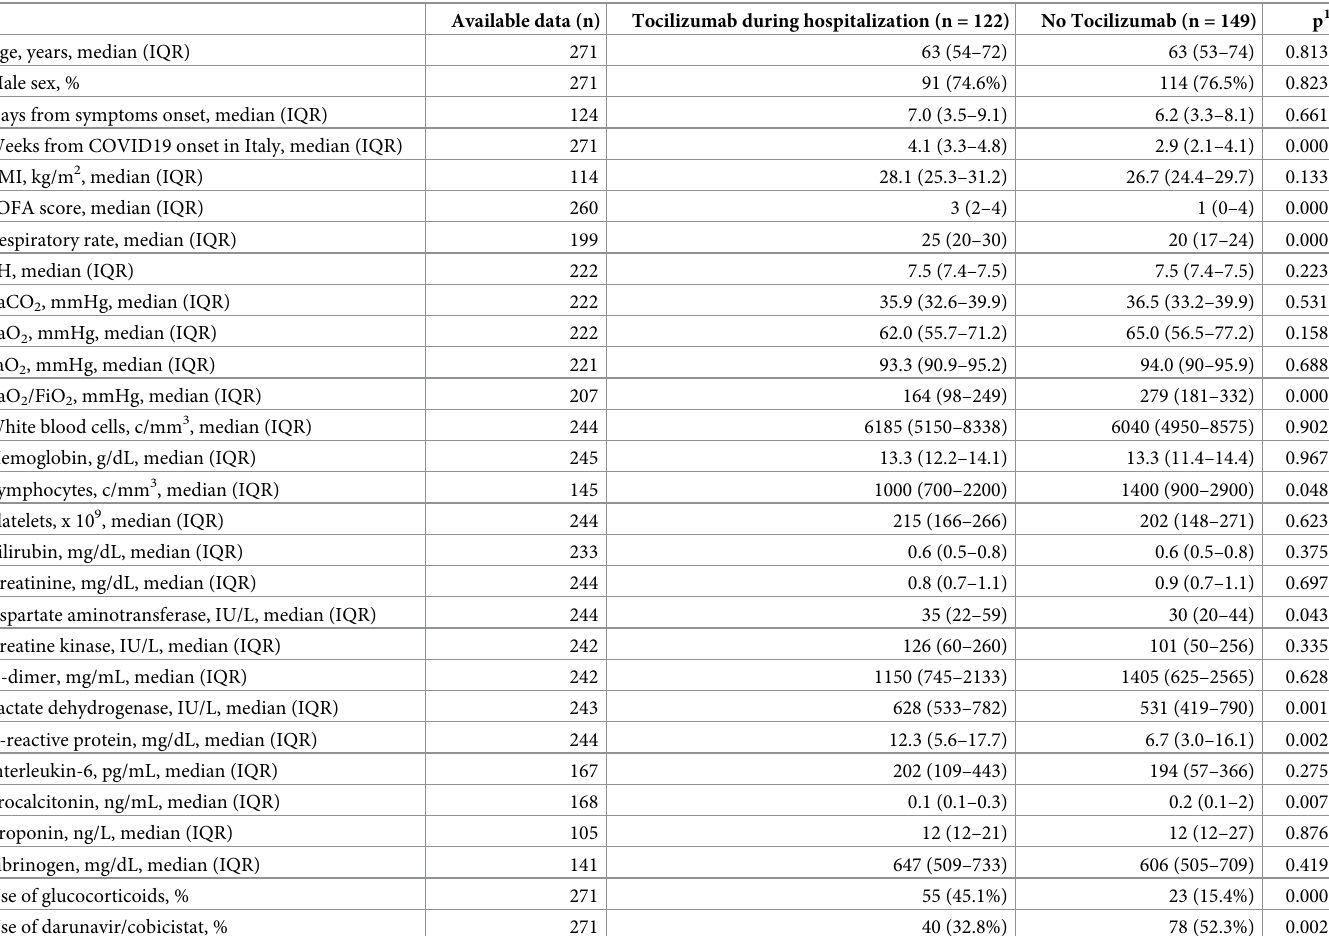
Table 1. Descriptive characteristics of patients at hospital